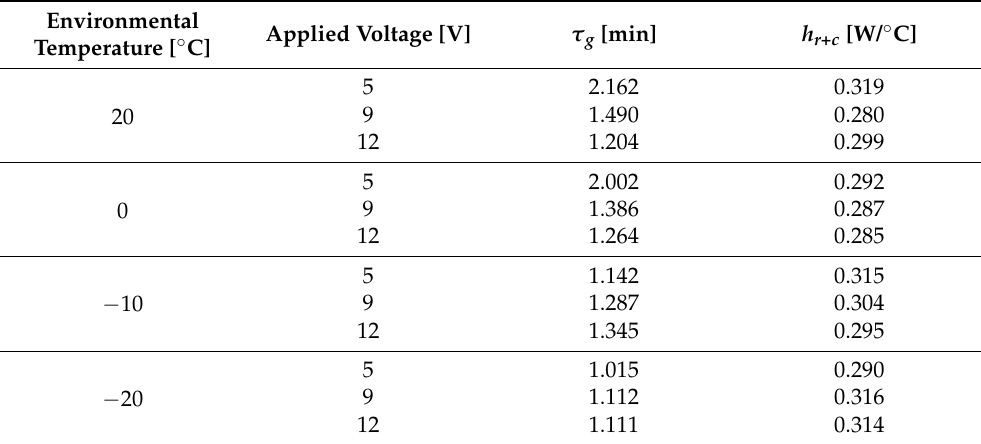
Figure 8. Average change in the heating-characteristic growth-time constant ( τ g ) and the effective heat transferred ( h r+c ) with regard to ( a ) applied voltage and ( b ) environmental temperature. Table 1. Characteristic parameters ( τ g : the heating-characteristic growth-time constant, h r+c : the effective heat transferred) for electric-heating performance of MWCNT/PDMS composite film under different applied loads.